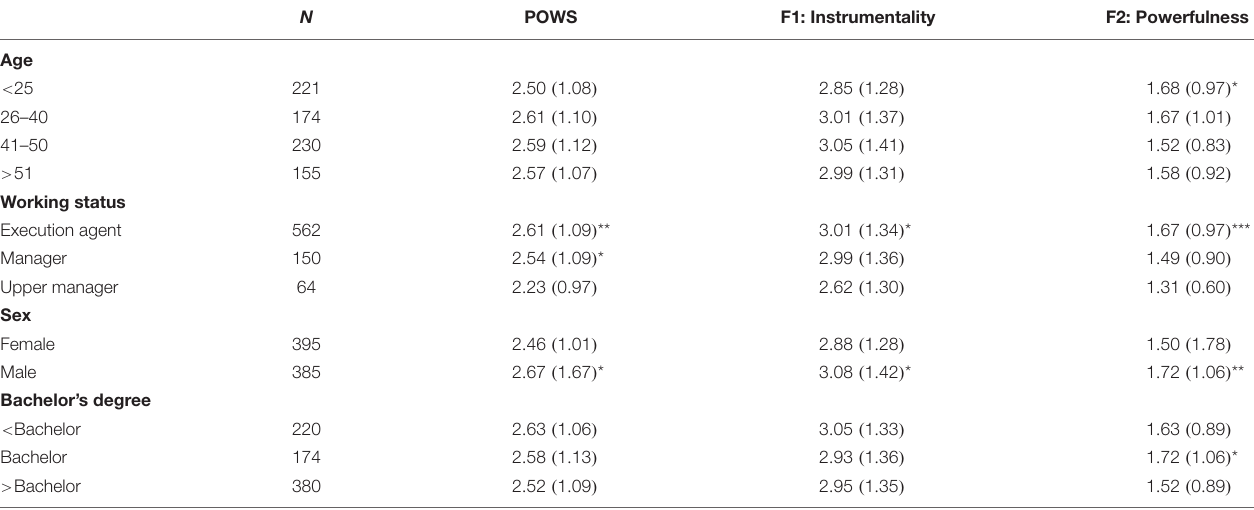
TABLE 5 | Mean (standard deviation) for POWS score depending on age, sex, working status, and degree of study ( N = 780). N POWS F1: Instrumentality F2: